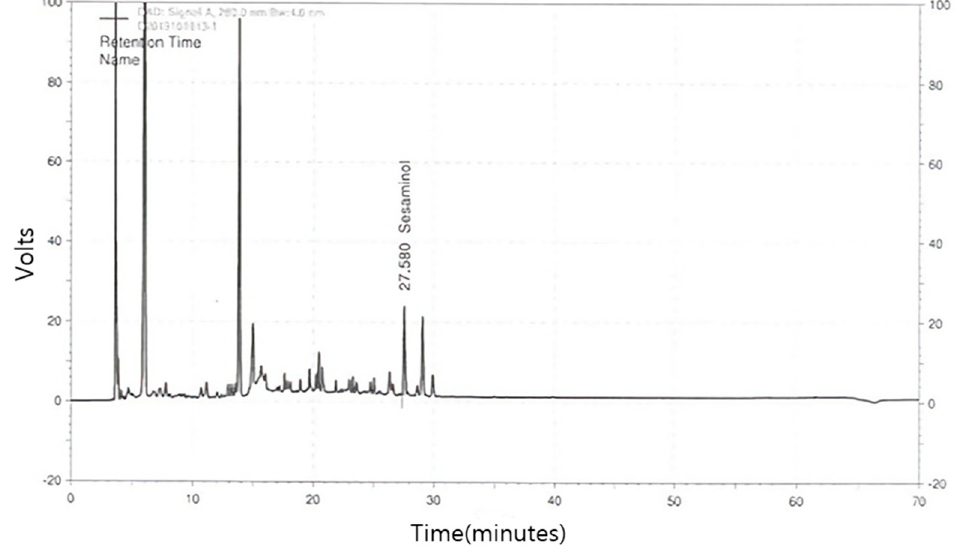
Figure 1. Representative chromatograms of SOCE (sesame oil cake extract) based on high-performance liquid chromatography (HPLC) analysis of sesaminol.